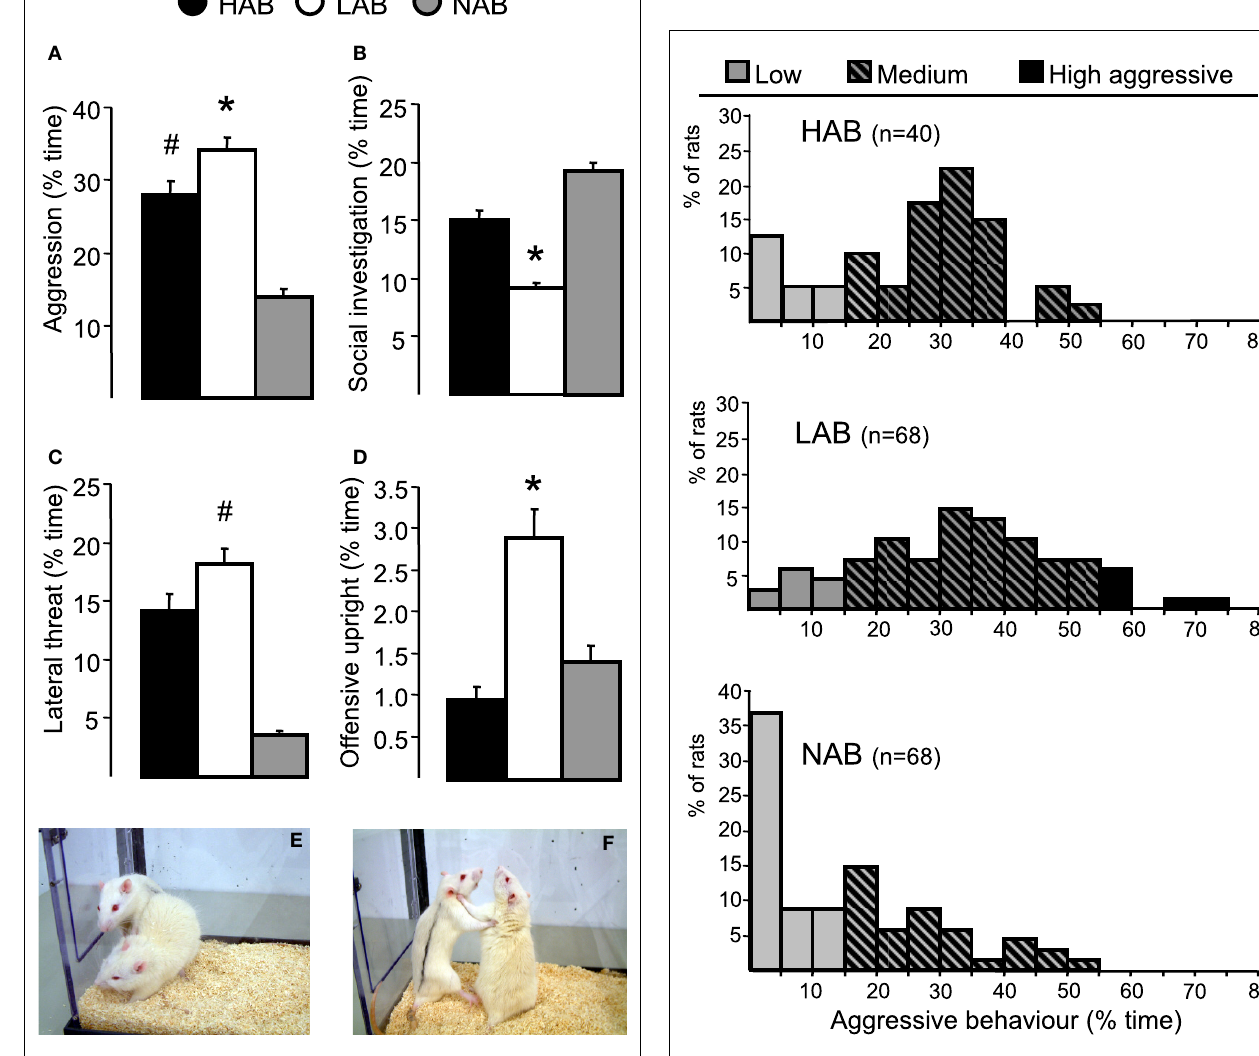
FIGURE 3 | Social behaviours of HAB, LAB and NAB male rats during the 10-min RI test: (A) aggressive behaviour, (B) social investigation, (C) lateral threat, and (D) offensive upright. (E) Lateral threat and (F) offensive upright displayed by the resident towards the intruder (intruder is marked with black lines). * p < 0.05 vs. NAB and HAB, # p < 0.05 vs. NAB. Data are presented as mean + SEM.